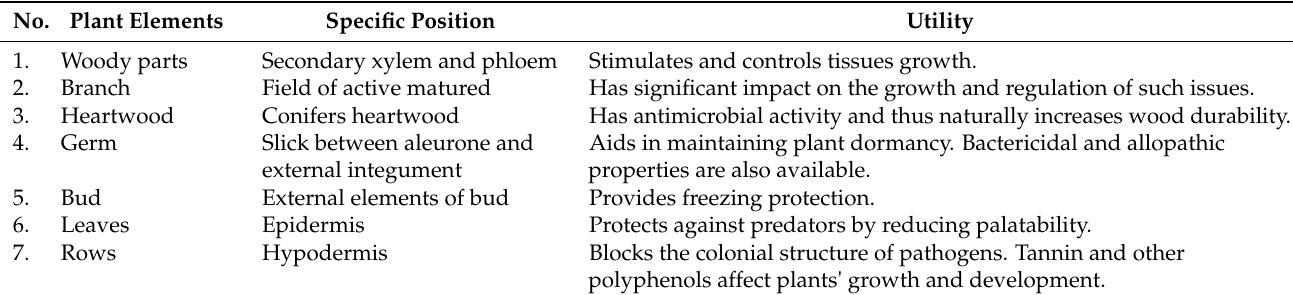
Table 1. The presence of tannins in various elements of plants and their vital functions [46,48,49].